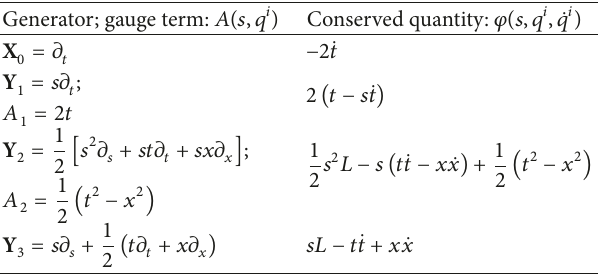
Table 23: Conserved quantities corresponding to each Noether